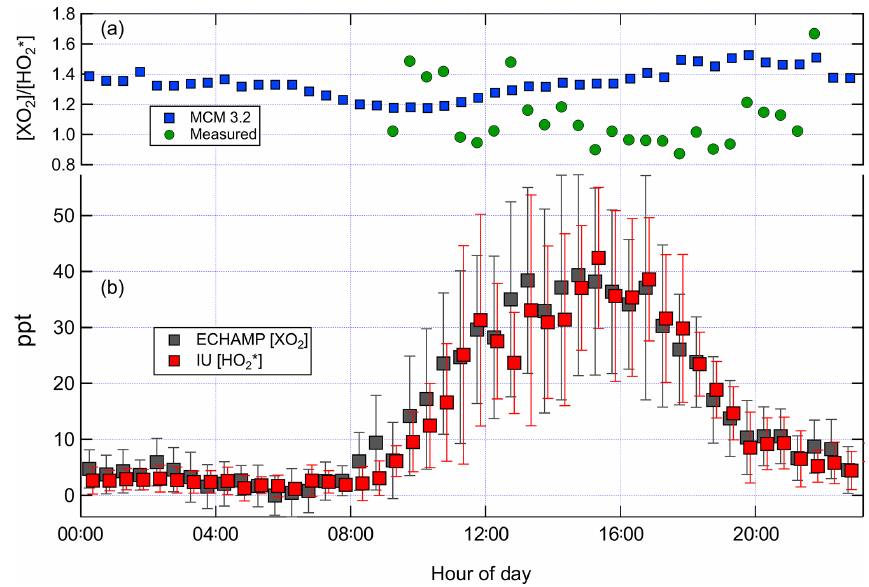
Figure 5. (b) Mean diurnal profile of ECHAMP XO 2 and IU LIF-FAGE HO ∗ measurements for the 9d in which both instruments were 2 operational. The HO ∗ values are displayed with a 6min horizontal offset for clarity. The error bars indicate the ± 1 standard deviation of the 2 ] ratio – both measured by the two instruments measured concentrations in each 30min time bin during those 9d. (a) shows the [ XO 2 ] / [ HO ∗ 2 and modeled using the MCM 3.2 chemical mechanism. The measured ratio is only shown for time periods between 09:00 and 22:00 due to the poor signal-to-noise ratios for the nighttime